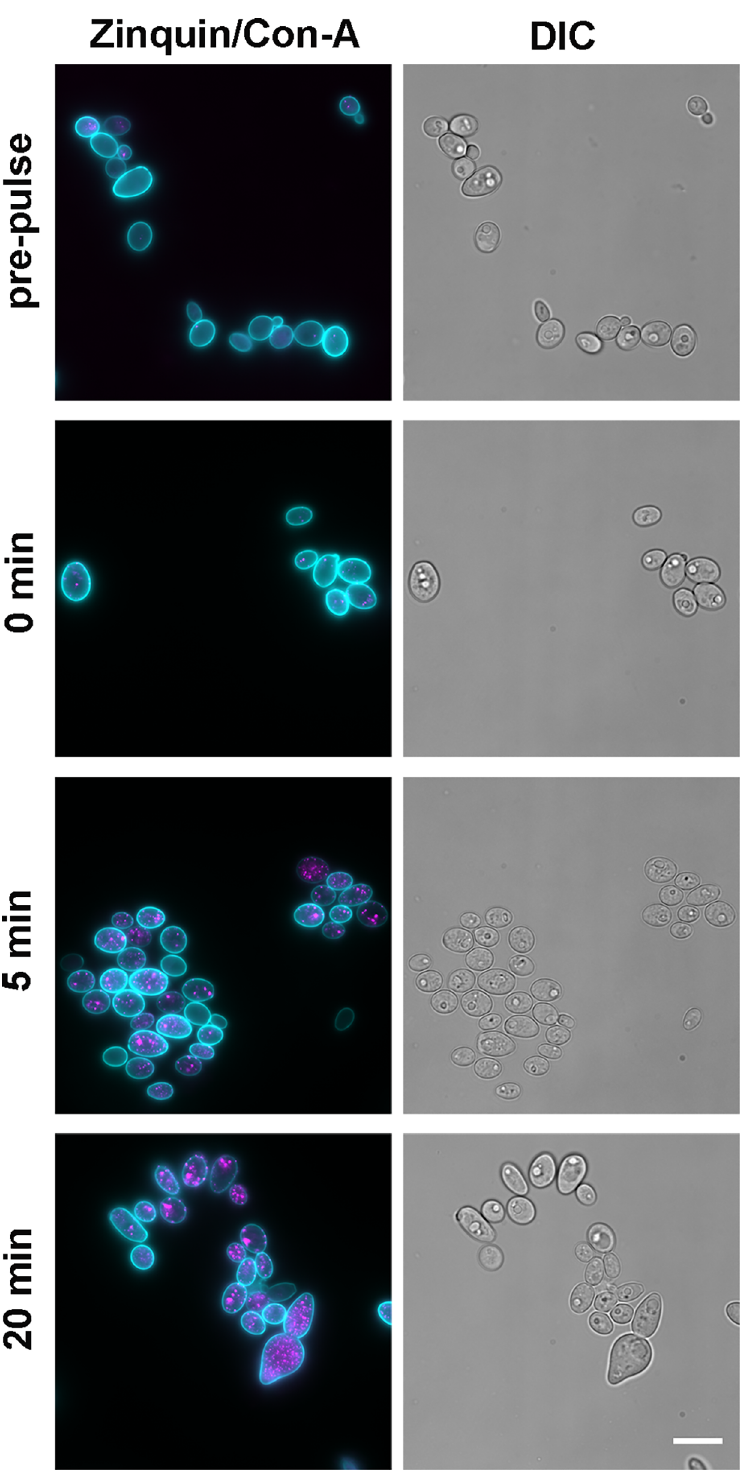
Fig 7. Kinetics of zincosome formation in C . albicans . Cells were incubated overnight in YNB-zinc-dropout medium (SD0) to deplete zincosomes and pulsed with 25 μM ZnSO 4 for indicated time points. Cells were then stained with zinquin to probe for zincosomal zinc and the cell wall stained with Concanavalin A conjugated to Alexa-647. Left hand column shows false colour overlay of cell wall (cyan) and zincosomes (magenta). Right hand column shows DIC; Experiment performed three times and representative images